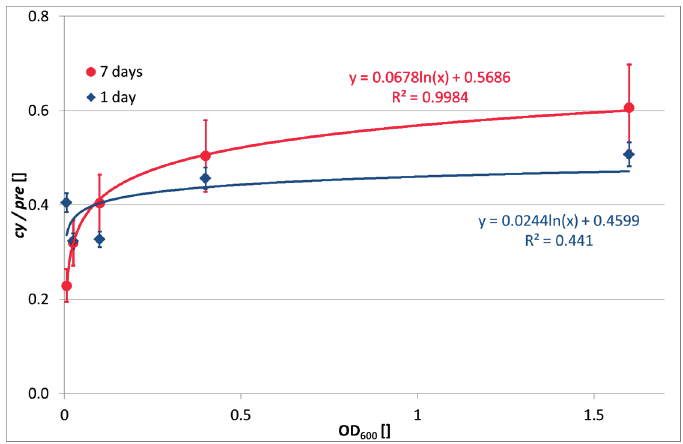
Figure 1. Relationship between biomass of P. denitrificans (expressed as OD 600 of the input bacterial suspension) and cy/pre PLFA indicator at day 1 (blue diamonds) and day 7 (red circles) after encapsulation. Used gels A0 to